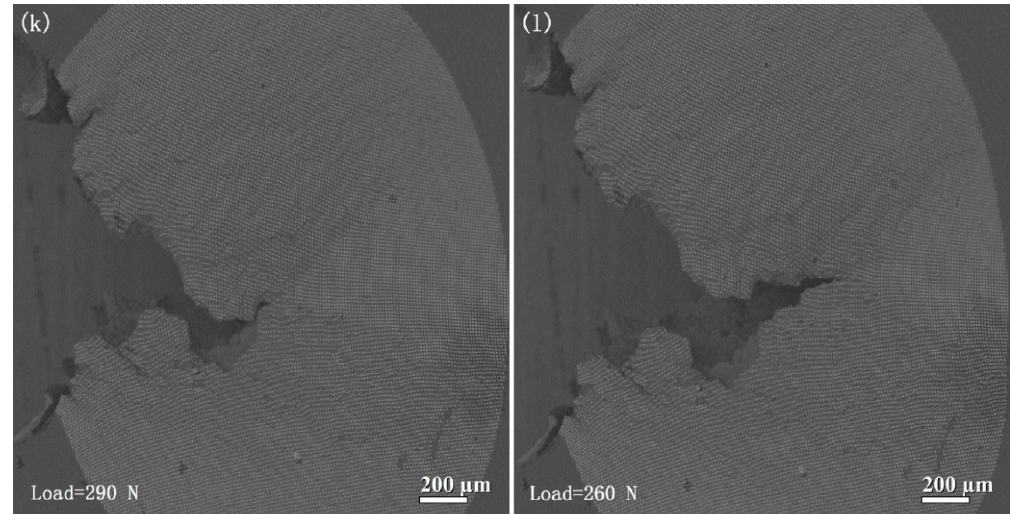
Figure 3. SEM images around the notch in the three-point bending test ( a ) before loading (0 N); ( b ) at 150 N during increasing load; ( c ) at 200 N during increasing load; ( d ) at 250 N during increasing load; ( e ) at 350 N during increasing load; ( f ) at maximum load 420 N; ( g ) at 390 N during decreasing load; ( h ) at 370 N during decreasing load; ( i ) at 350 N during decreasing load; ( j ) at 310 N during decreasing load; ( k ) at 290 N during decreasing load; ( l ) at 260 N during decreasing load.